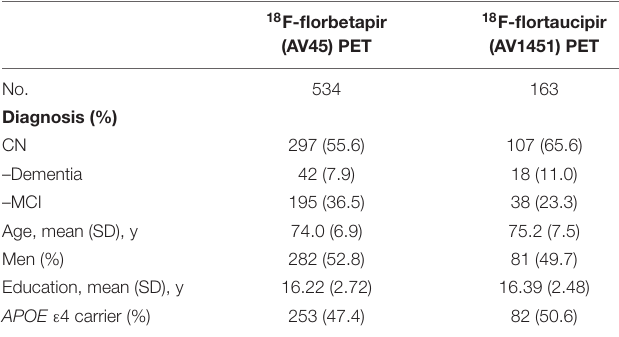
TABLE 2 | Characteristics of analyzed subjects by test modality and